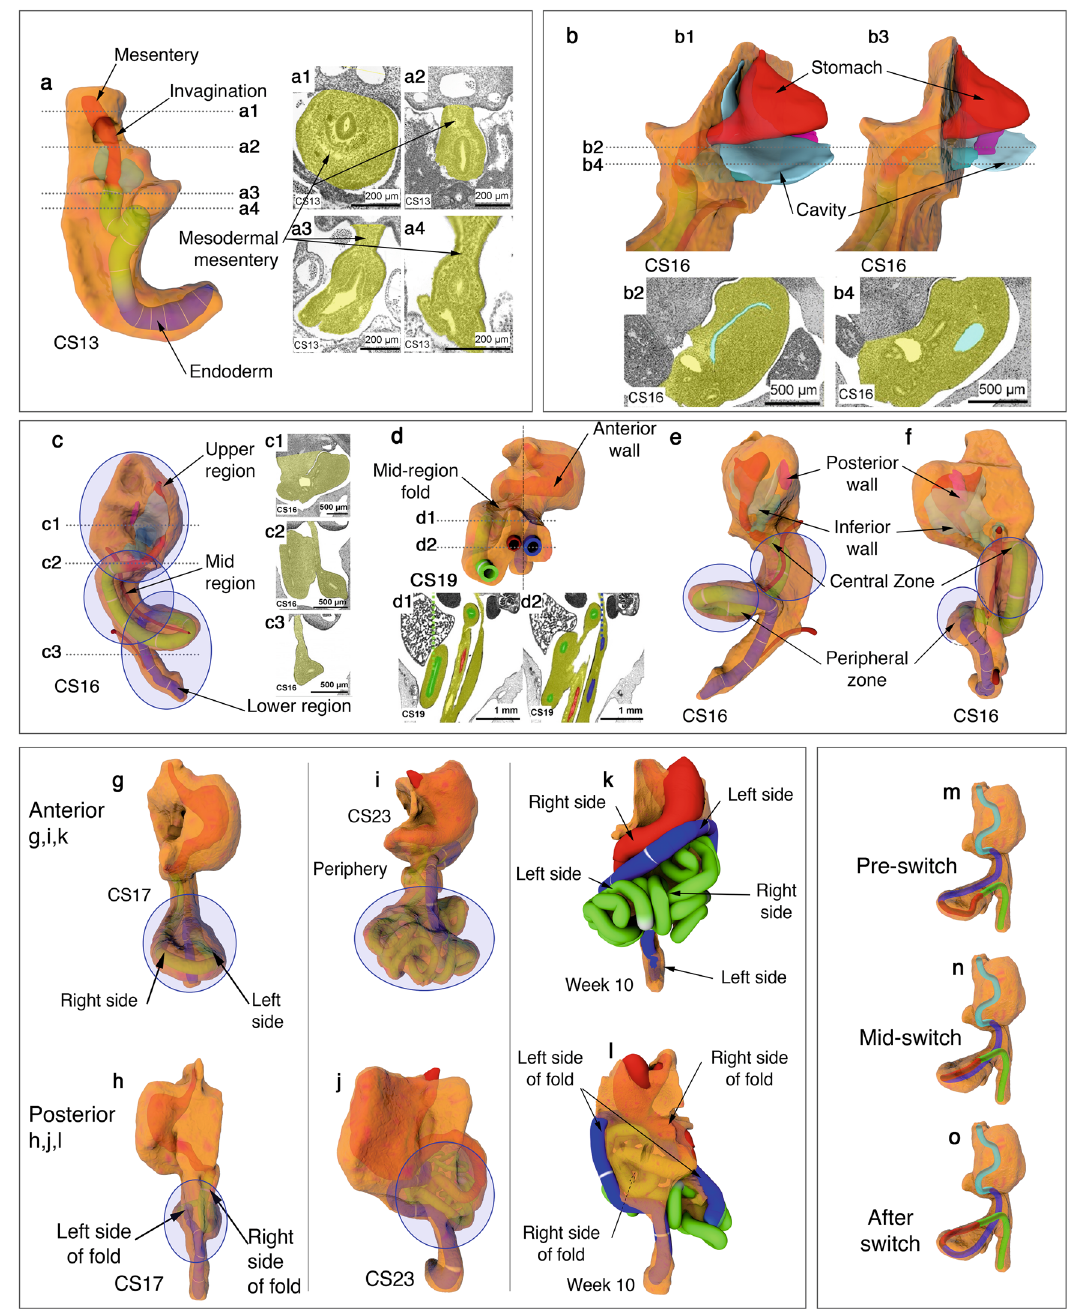
Fig. 1 Developing mesentery. a Photograph of a digitally reconstructed mesentery (yellow) at Carnegie stage (CS) 13. a1 – 4 Photomicrographs at levels indicated. b1 – 3 Photographs of the reconstructed mesentery at CS 16. b2 , 4 Photomicrographs of sections at levels indicated. c1 – 4 Photographs and photomicrographs of mesenteric regions at CS16. d1 – 2 Photographs and photomicrographs of the anterior aspect of the mid-region fold. Photographs demonstrating anterior ( e ) and posterior ( f ) aspects of the mid-region at CS 16. g – l Photographs showing anterior and posterior aspects of the developing mid-region. m – o Schematic depiction of the mid-region